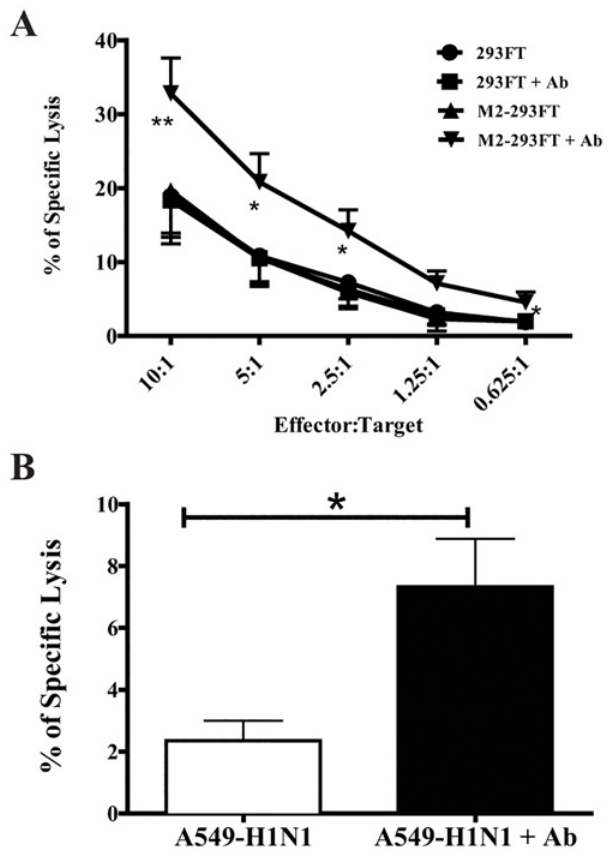
Fig 2. The anti-M2e Ab1-10 mAb induces freshly isolated NK cell-mediated ADCC. (A) Effectors (freshly isolated NK cells) and targets (293FT and M2-293FT cells) were co-incubated at different ratios either in the presence or absence of Ab1-10 mAb (Ab). The percentage of specific lysis is shown. Error bars represent the standard error of the mean (SEM) from five independent experiments with freshly isolated NK cells from five donors ( * P < 0.05, ** P < 0.01). (B) Influenza infected A549 cells were co-cultured with human NK cells from healthy donors in the absence or presence of Ab1-10 mAb (Ab). The percentage of lysis is shown. Error bars represent the SEM from four independent experiments with freshly isolated NK cells from four donors ( * P <